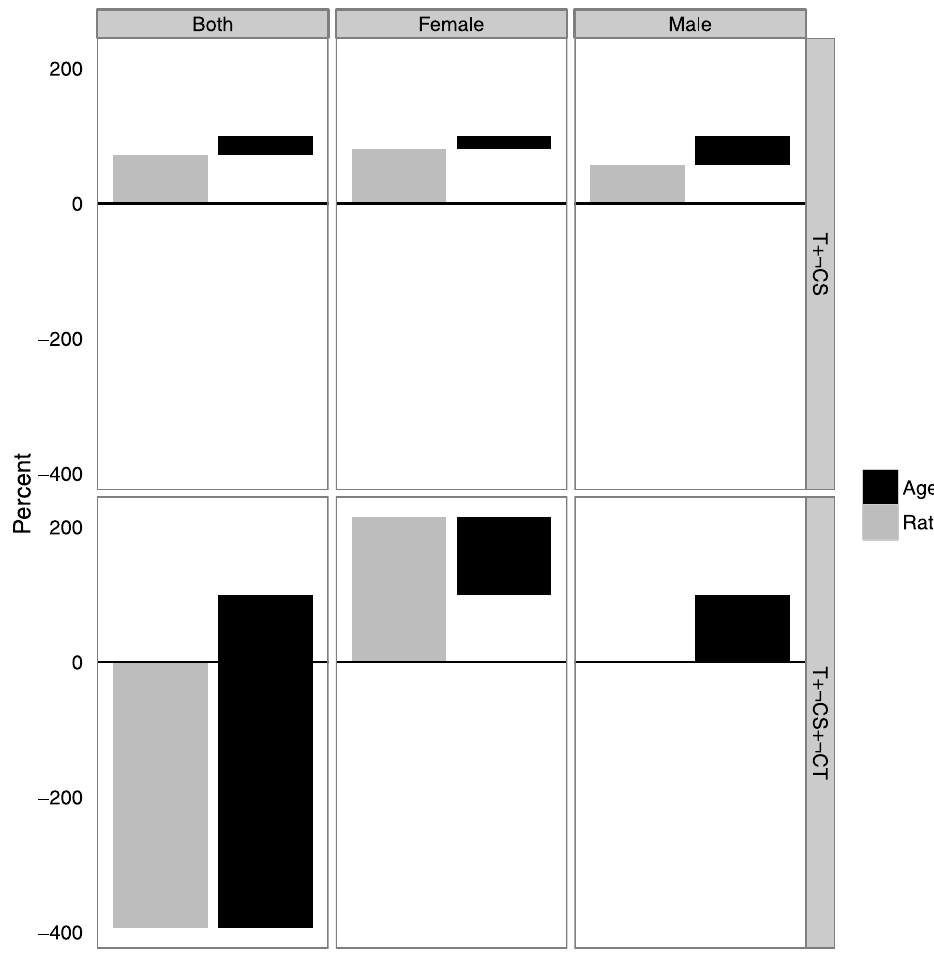
Figure 4. Decomposition of sub-group crude rates into rate and age composition differences using the 2-stage approach, Agincourt HDSS 2010 – 2011. Rate and age differences sum to 100% for each sex subgroup. For those who were contacted we use Ct, for those who consented we use CS, and for those who were tested T. We use the negation operator : to indicate ‘the opposite of’ – i.e. : CT means ‘not contacted’.